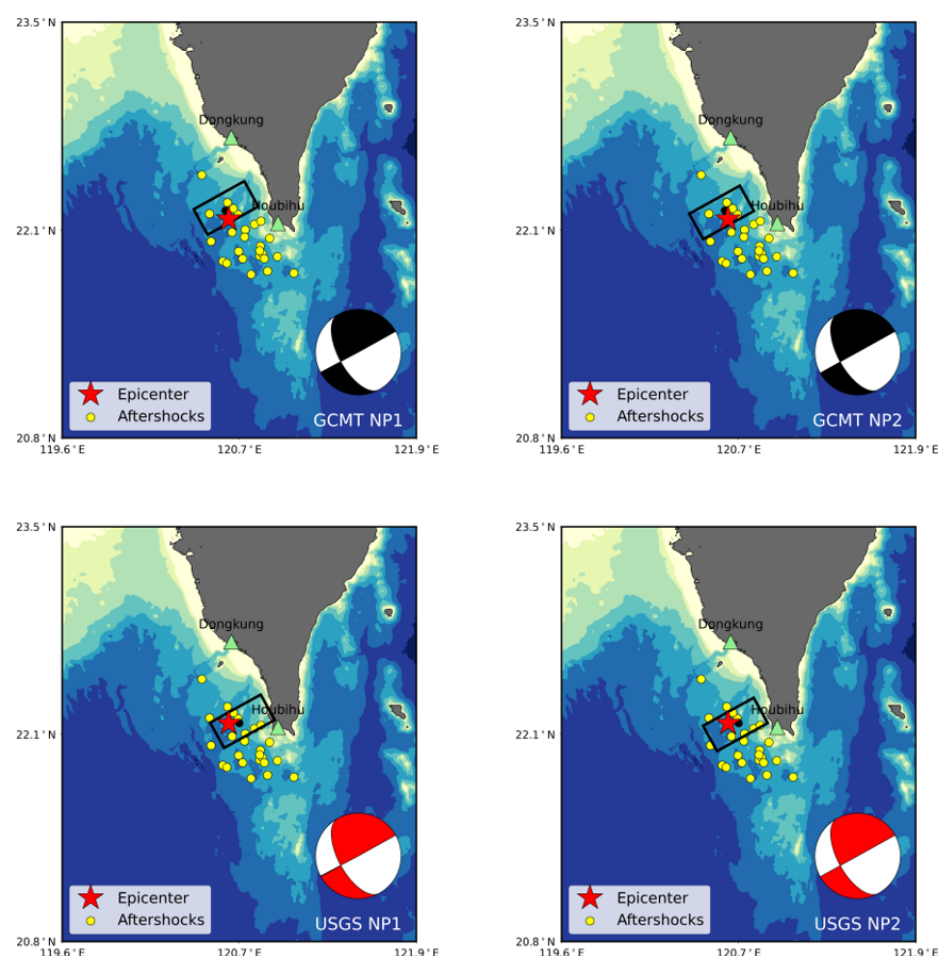
Figure 16. Simple fault models of the second earthquake ( M w 6.9) using the focal mechanisms from GCMT and USGS. The green triangles indicate the tide gauge stations, red stars indicate the epicenter, yellow circles indicate aftershocks, and the black rectangles indicate the fault